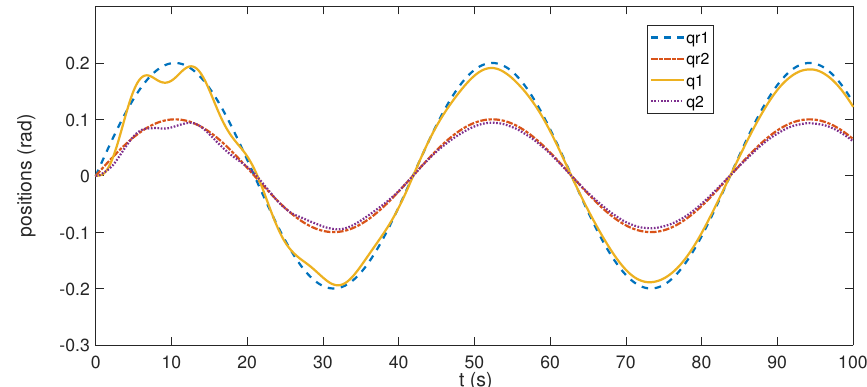
Figure 7. Position tracking performance under time-varying delay.